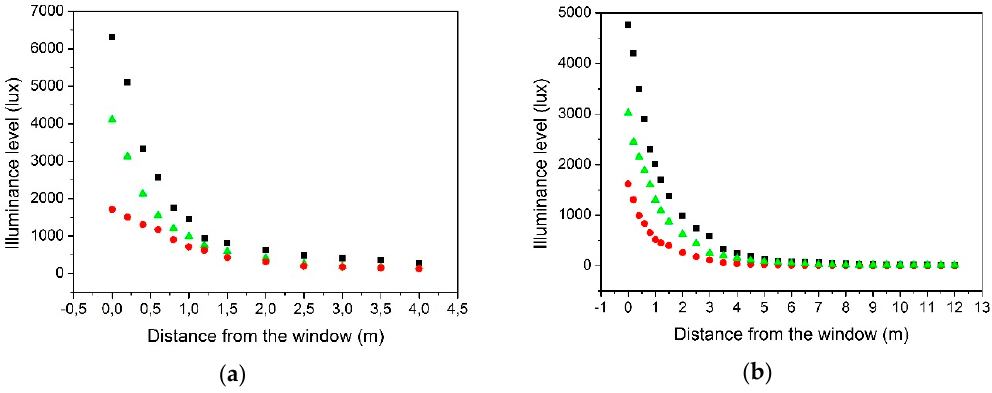
Figure 3. Daylight illuminance level distributions ( a ) at Office 1 depth and ( b ) at Corridor depth; ■ — on 12 May 2016 at 14:30, ● —on 13 May 2016 at 10:10, ▲ —on 19 May 2016 at 10:15.